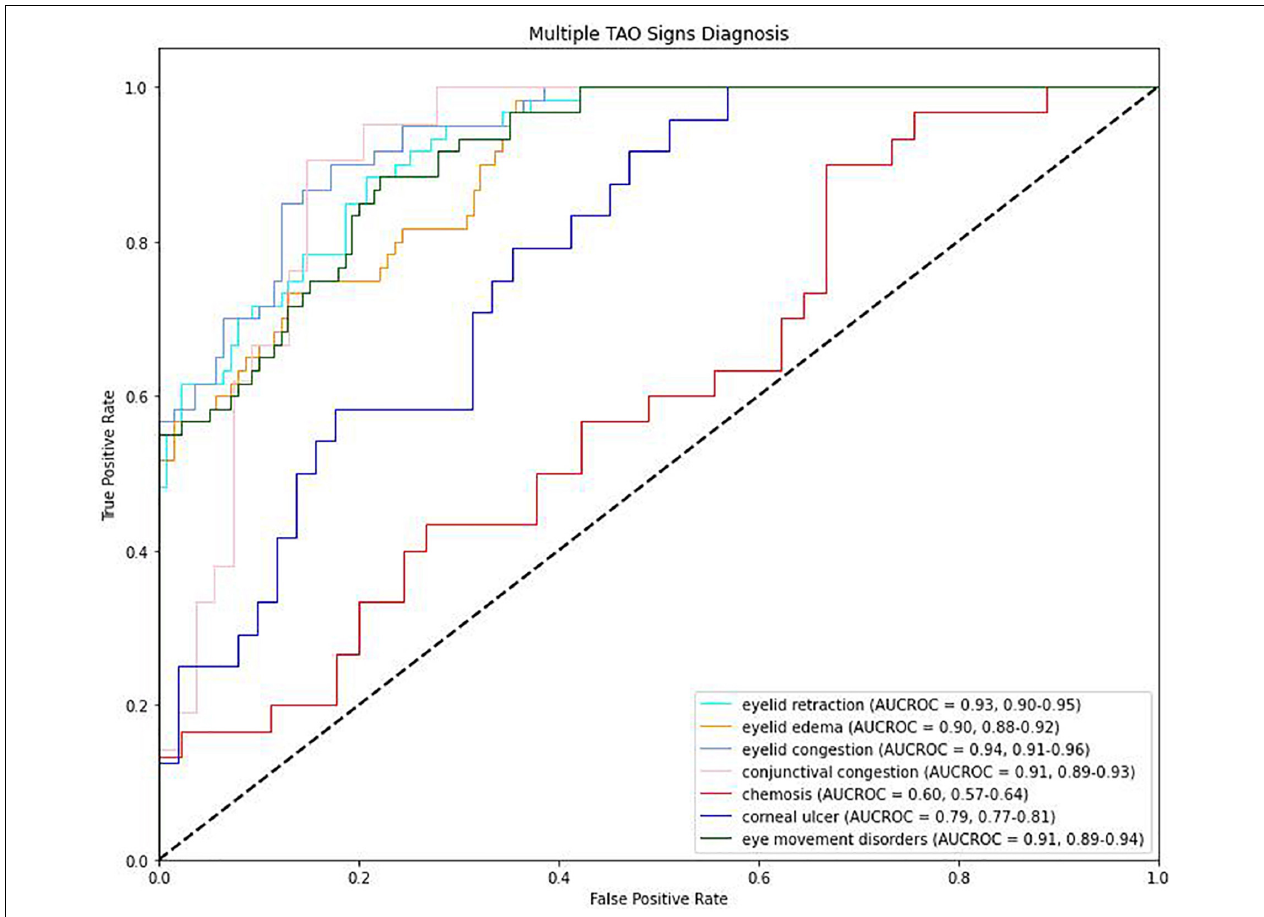
FIGURE 4 | Receiver operating characteristic (ROC) curves for the detection of signs of thyroid-associated ophthalmopathy.